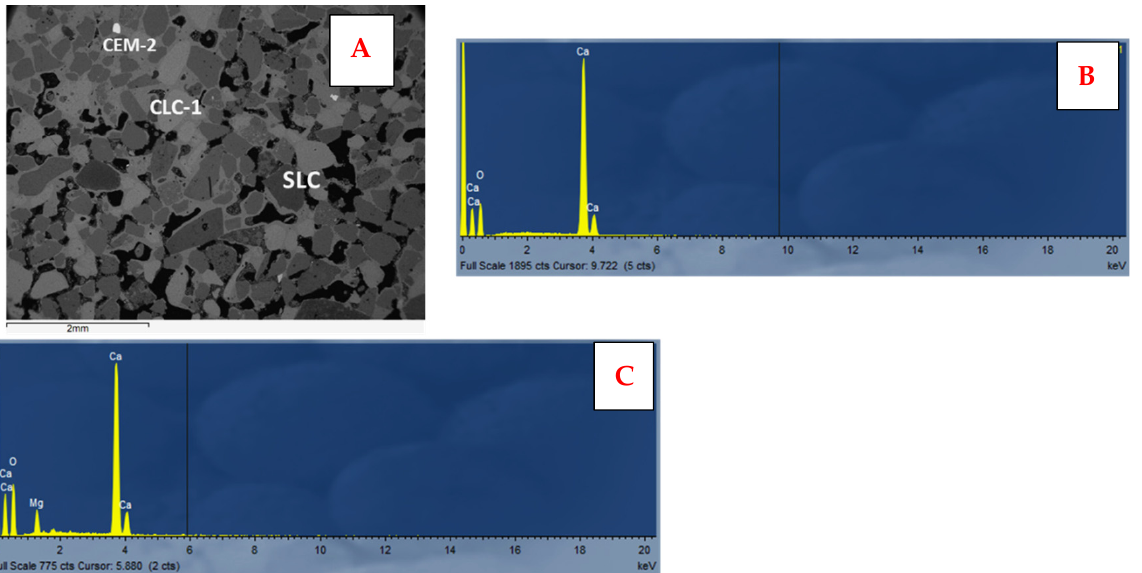
Figure 10. ( A ): BSE-SEM image indicating textural characteristics of KAN3 sample; ( B , C ): EDS spectra corresponded to the detrital carbonate grain (see CLC-1 of Figure 10A) and cement phase (see CEM-2 of Figure 10A). Dark gray: siliceous material; Light gray: detrital carbonates; intermediate gray: cement; Black: pore; CEM: cement; CLC: calcareous lithoclast.